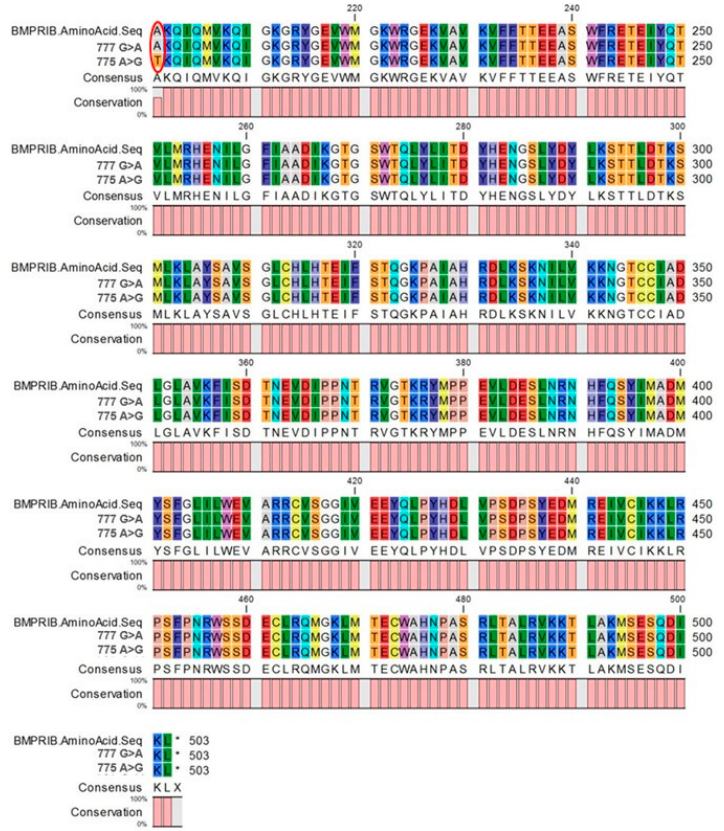
Figure 2. Polypeptide changes in presence of SNPs in BMPR1B gene in Markhoz goat breed (CLC Main workbench.7.7.1 version).